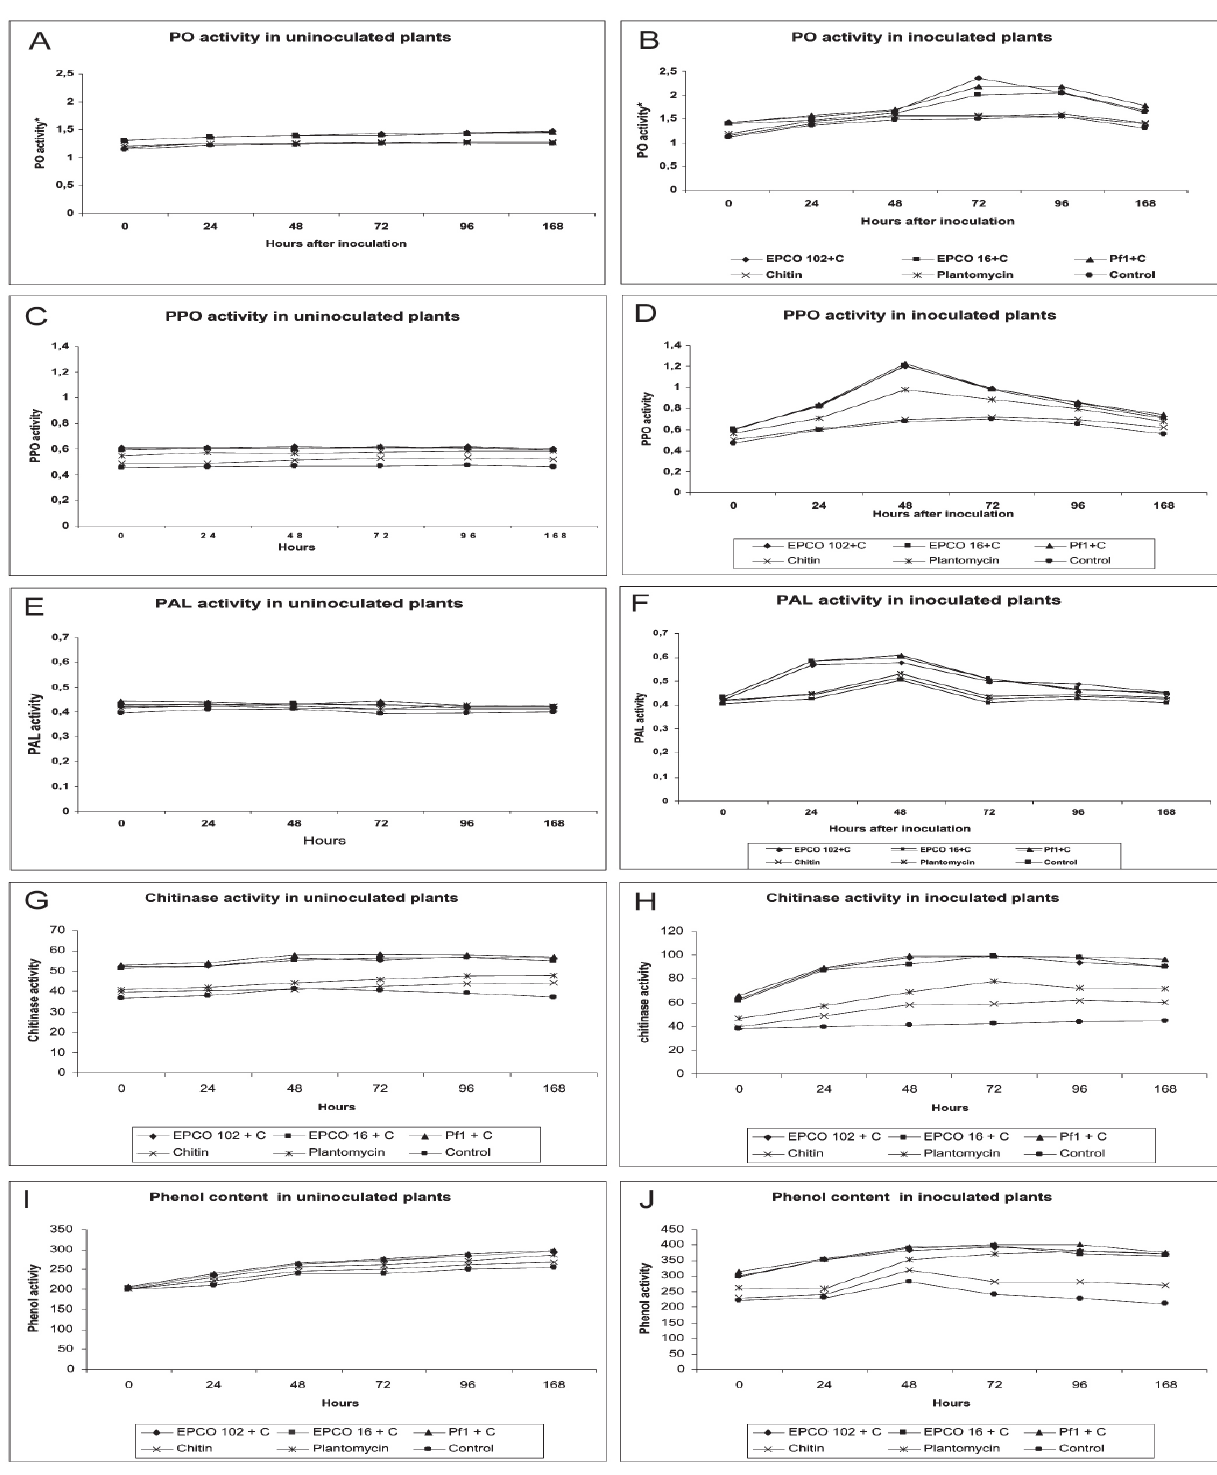
Fig. 1. Bacterial blight infection and induced systemic resistance in cotton